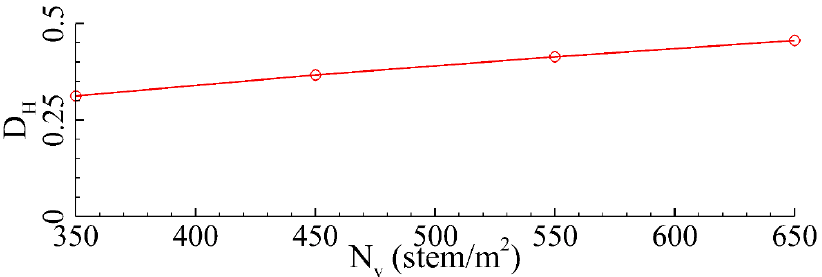
Figure 26. Dissipation rate of the local maximum wave height under different vegetation densities.